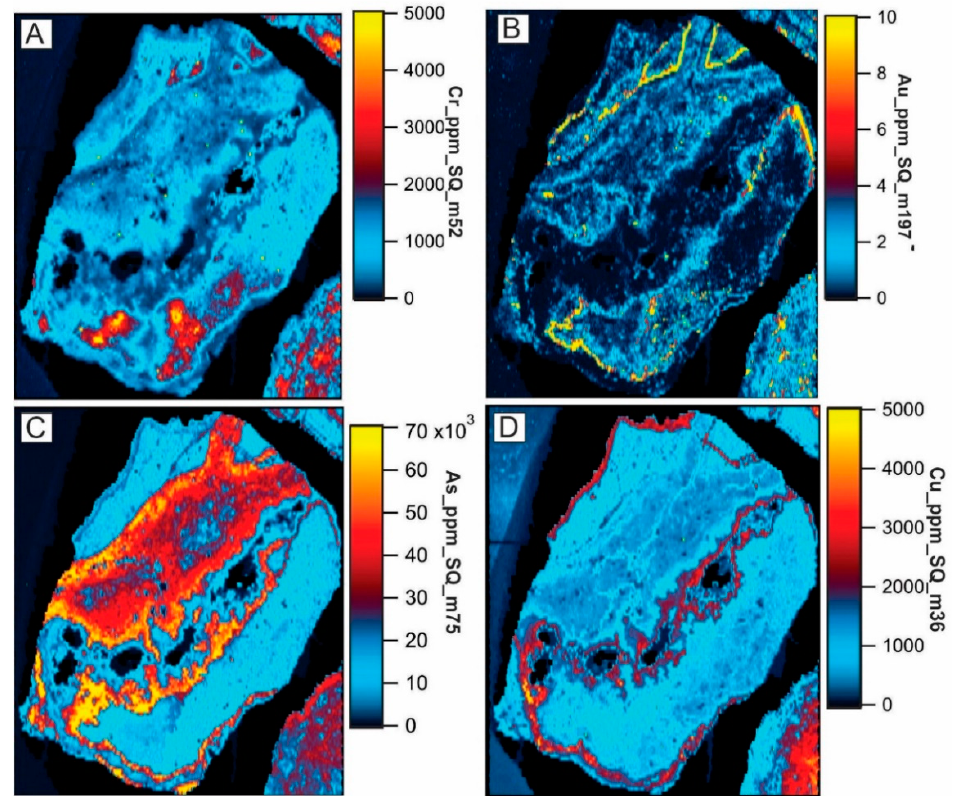
Figure 16. Laser ablation ICP-MS elemental maps showing Cr ( A ), Au ( B ), As ( C ) and Cu ( D ) for a ferruginous nodule (approximately 10 mm in diameter) formed in the Wollubar Sandstone (NWS).